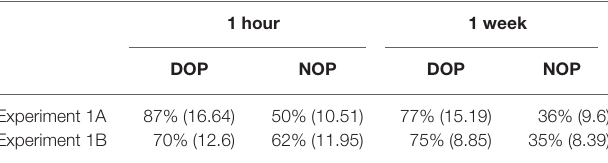
TABLE 1 | Mean percentages of correct responses and standard error of the mean (SEM; in parentheses) in the memory recognition tests as a function of Outcomes (DOP: differential outcomes procedure, NOP: non-differential outcomes procedure) and Time of testing (1 h, 1 week). Experiments 1A and